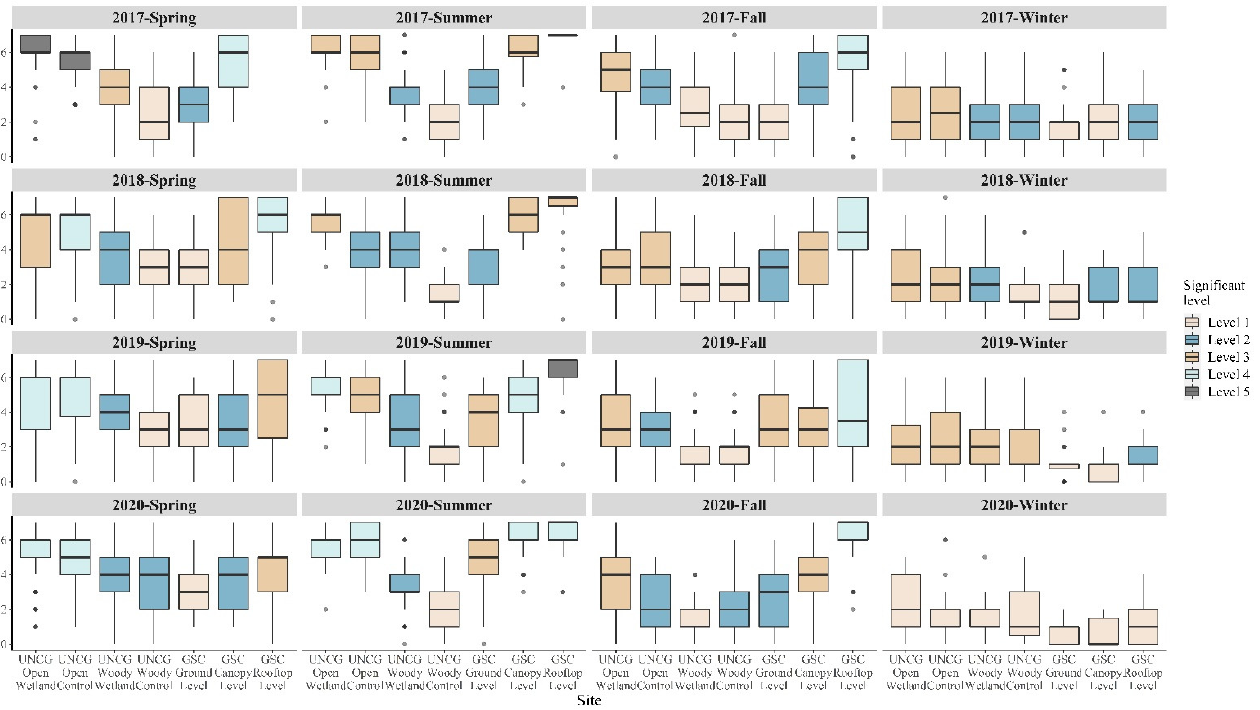
Figure 3. Boxplot (25–75% quantiles) for nightly species richness against sites within each season in Greensboro, North Carolina, USA. Post hoc Tukey HSD tests were used to determine species richness difference between sites, indicated by different colors. When two sites are shown in different colors/significant levels, they have different species richness.